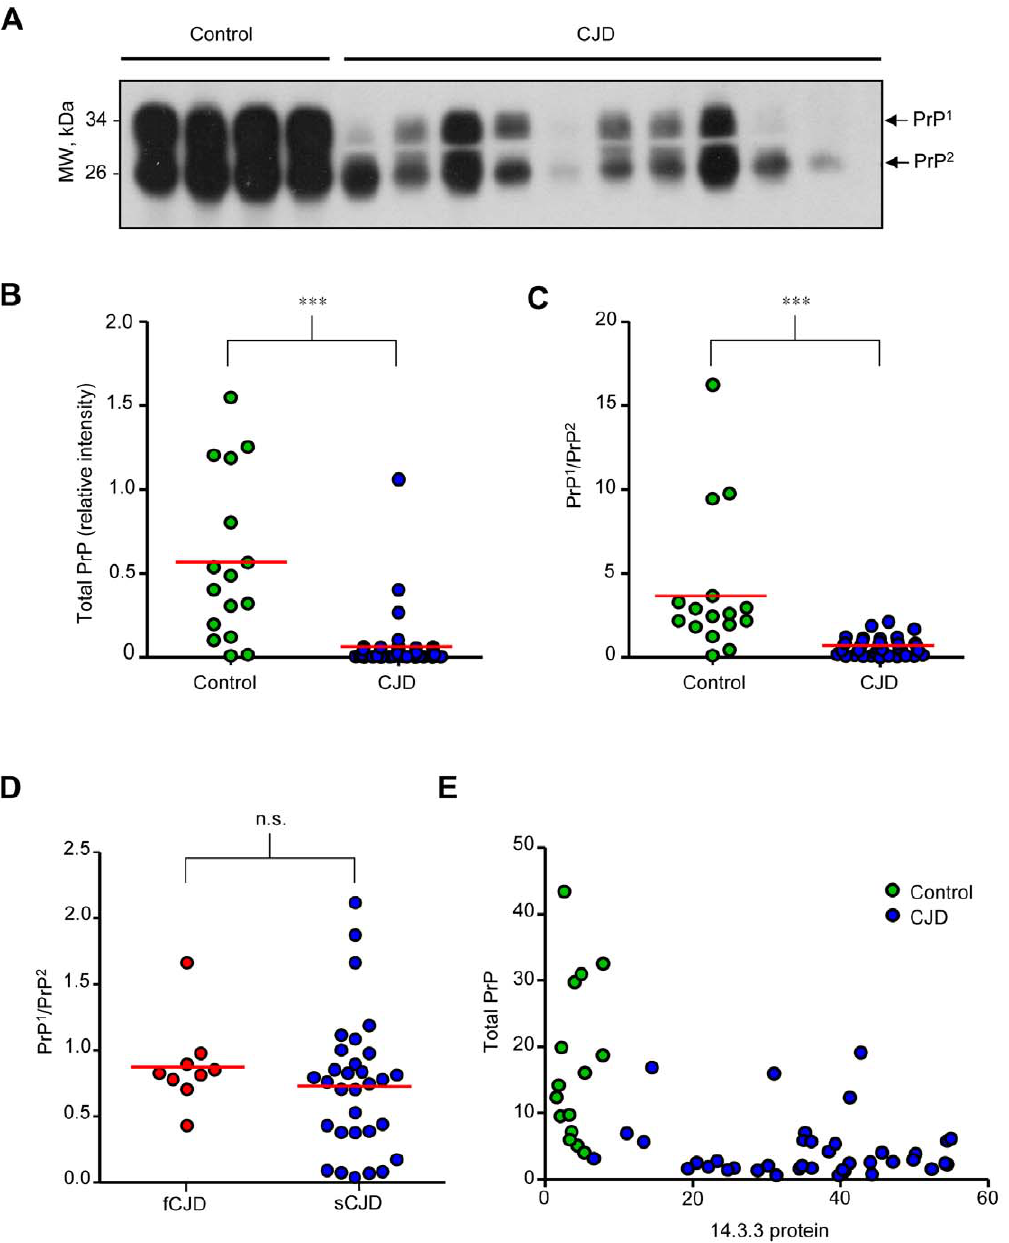
Figure 2. Altered PrP expression pattern in CSF of CJD patients. CSF samples from CJD patients (N=40) and non-CJD controls (N=16), were obtained by lumbar puncture. A. PrP levels in CSF were examined by Western blot. B. and C. Quantification of relative levels of total PrP protein in CSF and the ratio of the PrP band 1 (upper) and PrP band 2 (lower) in CSF, respectively. D. Comparison between ratios of PrP band 1 and 2 in sCJD versus fCJD E. Correlation of total PrP protein levels with 14-3-3 protein in each CSF samples presented in Fig 1. In B, C and D the red line represents the mean of all samples analyzed. Statistical significance was calculated using Student’s t-test.